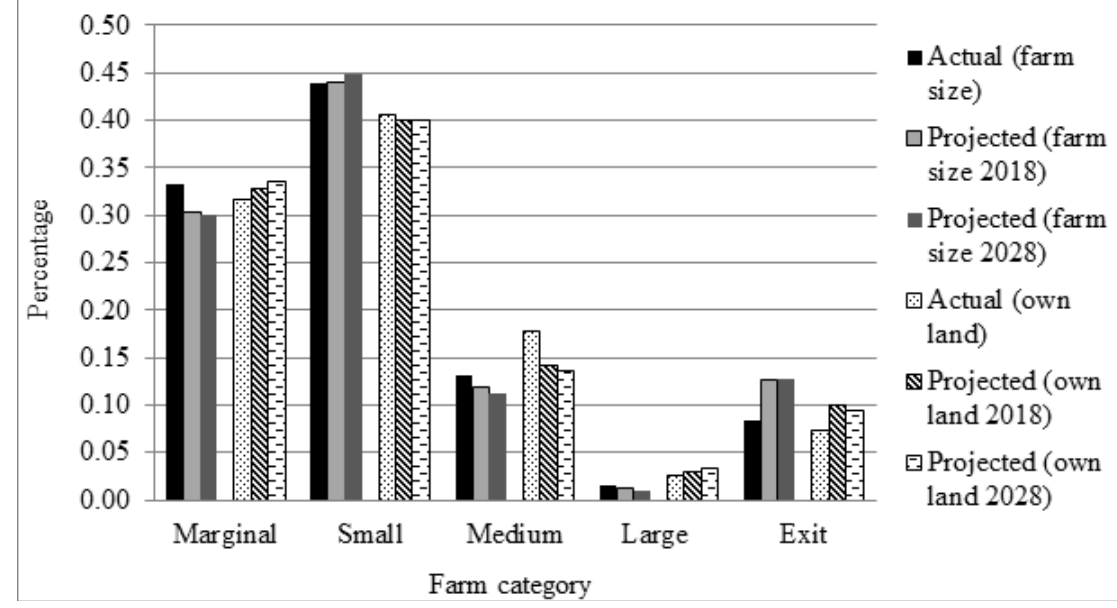
Figure 1: Actual and projected size distribution of farms for the period of 2008-2018-2028. Source: Author’s own